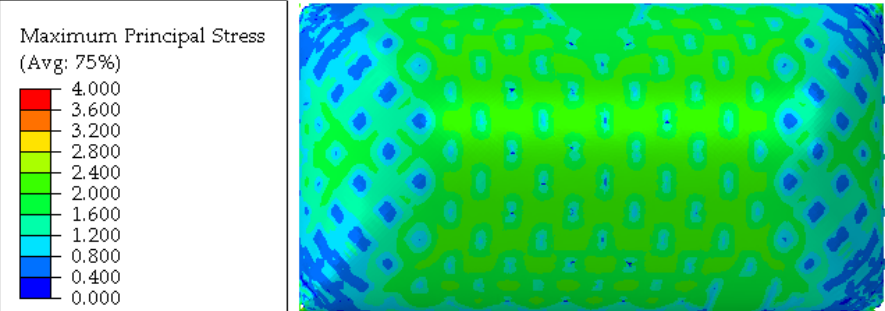
Figure 10. Stress of the model under pressure difference and gravity (MPa).